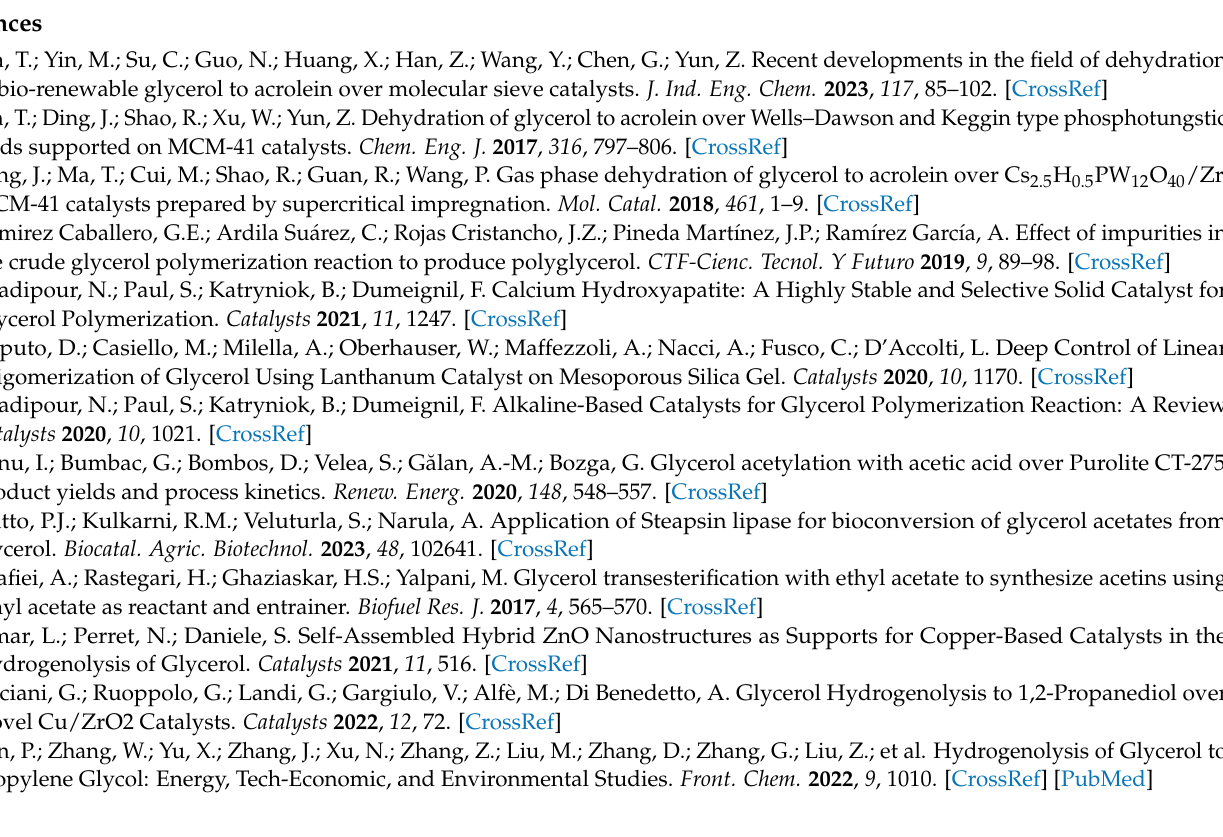
Figure S7. The GC-MS signals of methyl